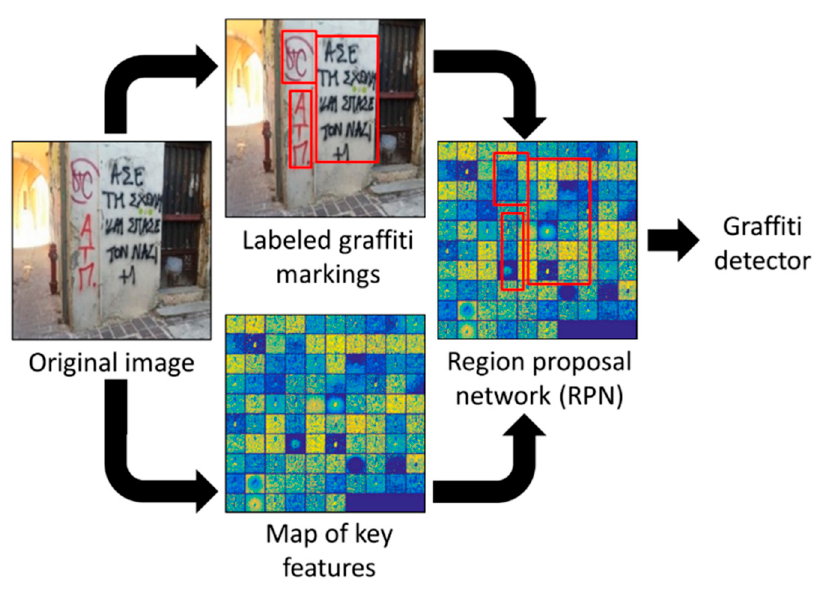
Figure 3. Faster R-CNN is a unified network of region proposals and key feature maps. This algorithm was used in this work to construct a robust graffiti detector.